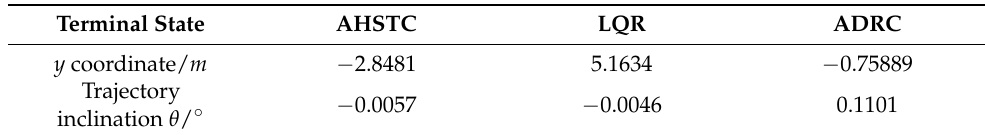
Table 3. Tracking error based on Simulation Analysis 2.